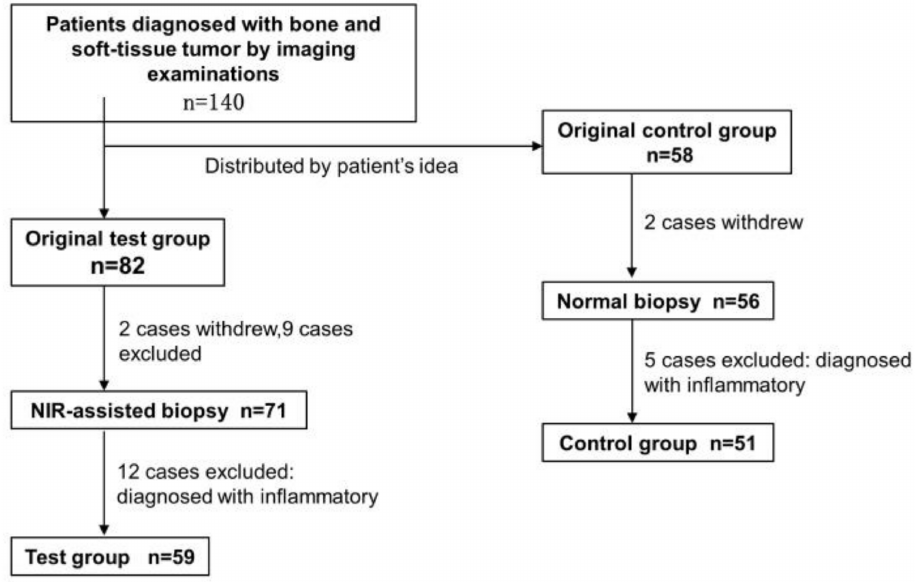
Figure 2. The flowchart of this